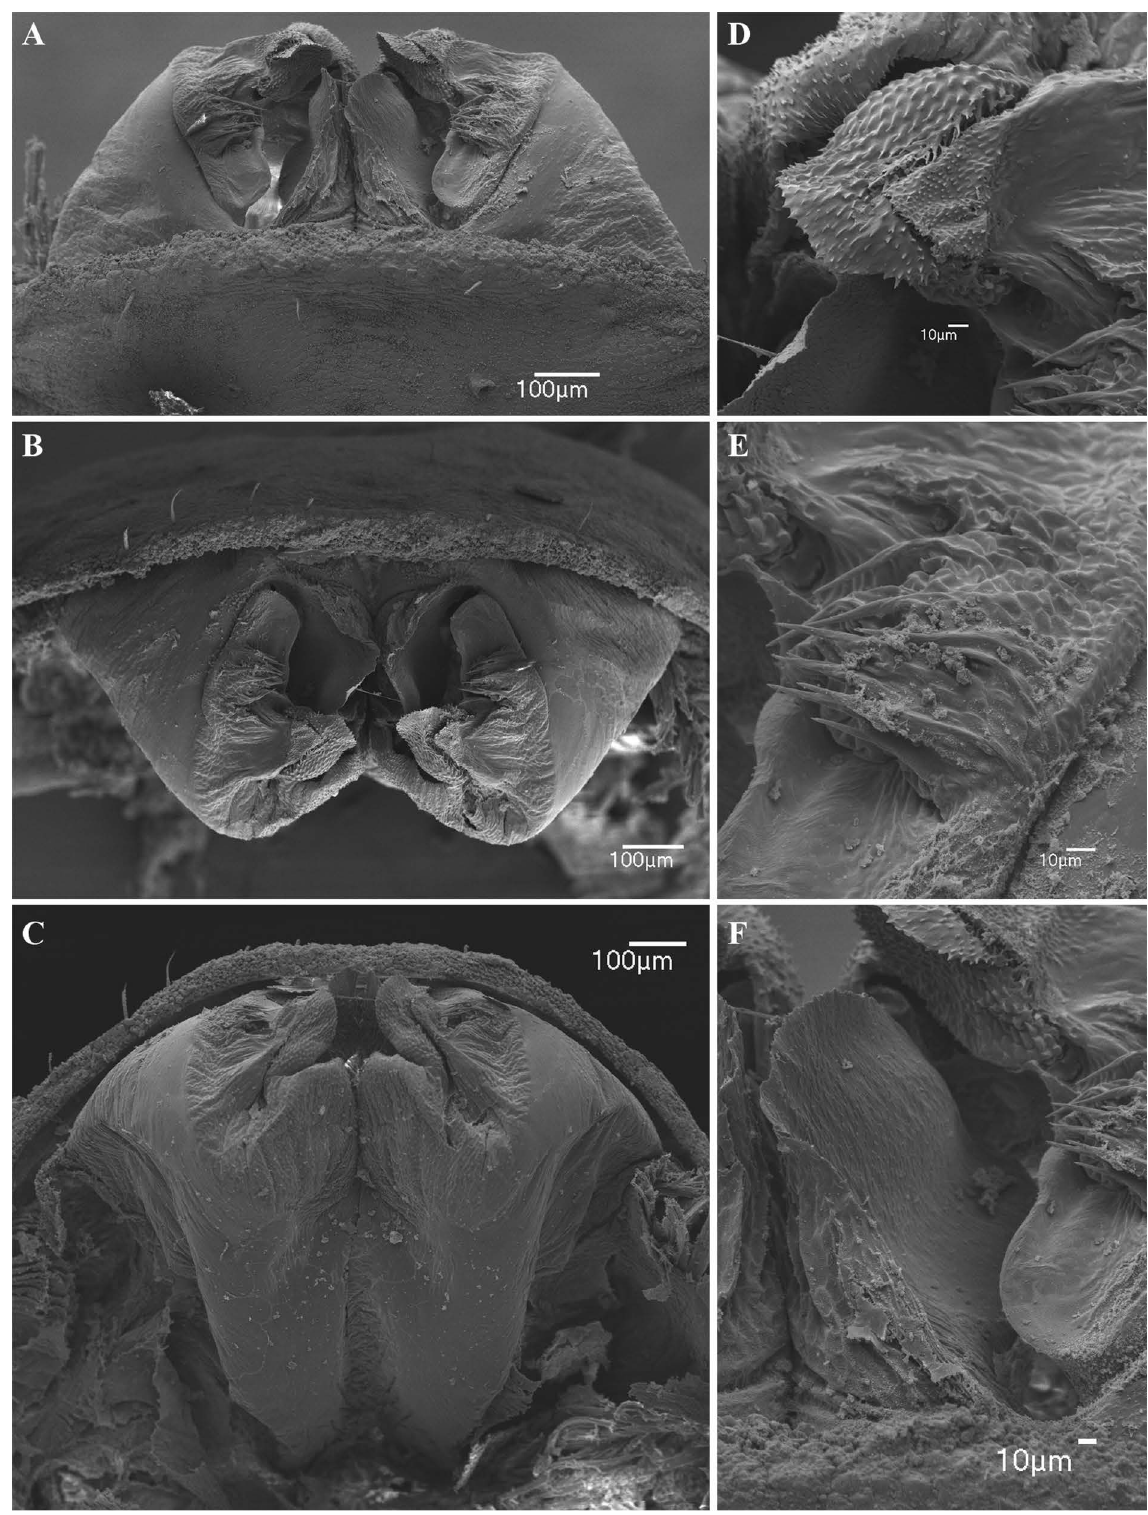
Fig. 102. Charinus pescotti Dunn, 1949 (AMCC [LP 6367]), male gonopod. A . Ventral view. B . Posterior view. C . Dorsal view. D . Lateral lobe 1 and dorsal lobe. E . Lateral lobe 2. F . Lamina medialis and processus